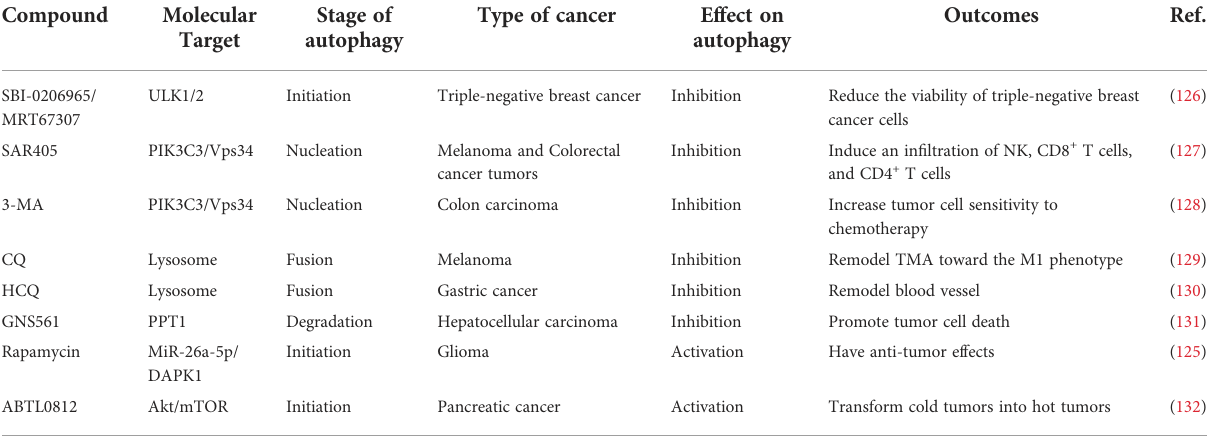
TABLE 2 The applied autophagy targeting agents in treatments in vivo and vitro